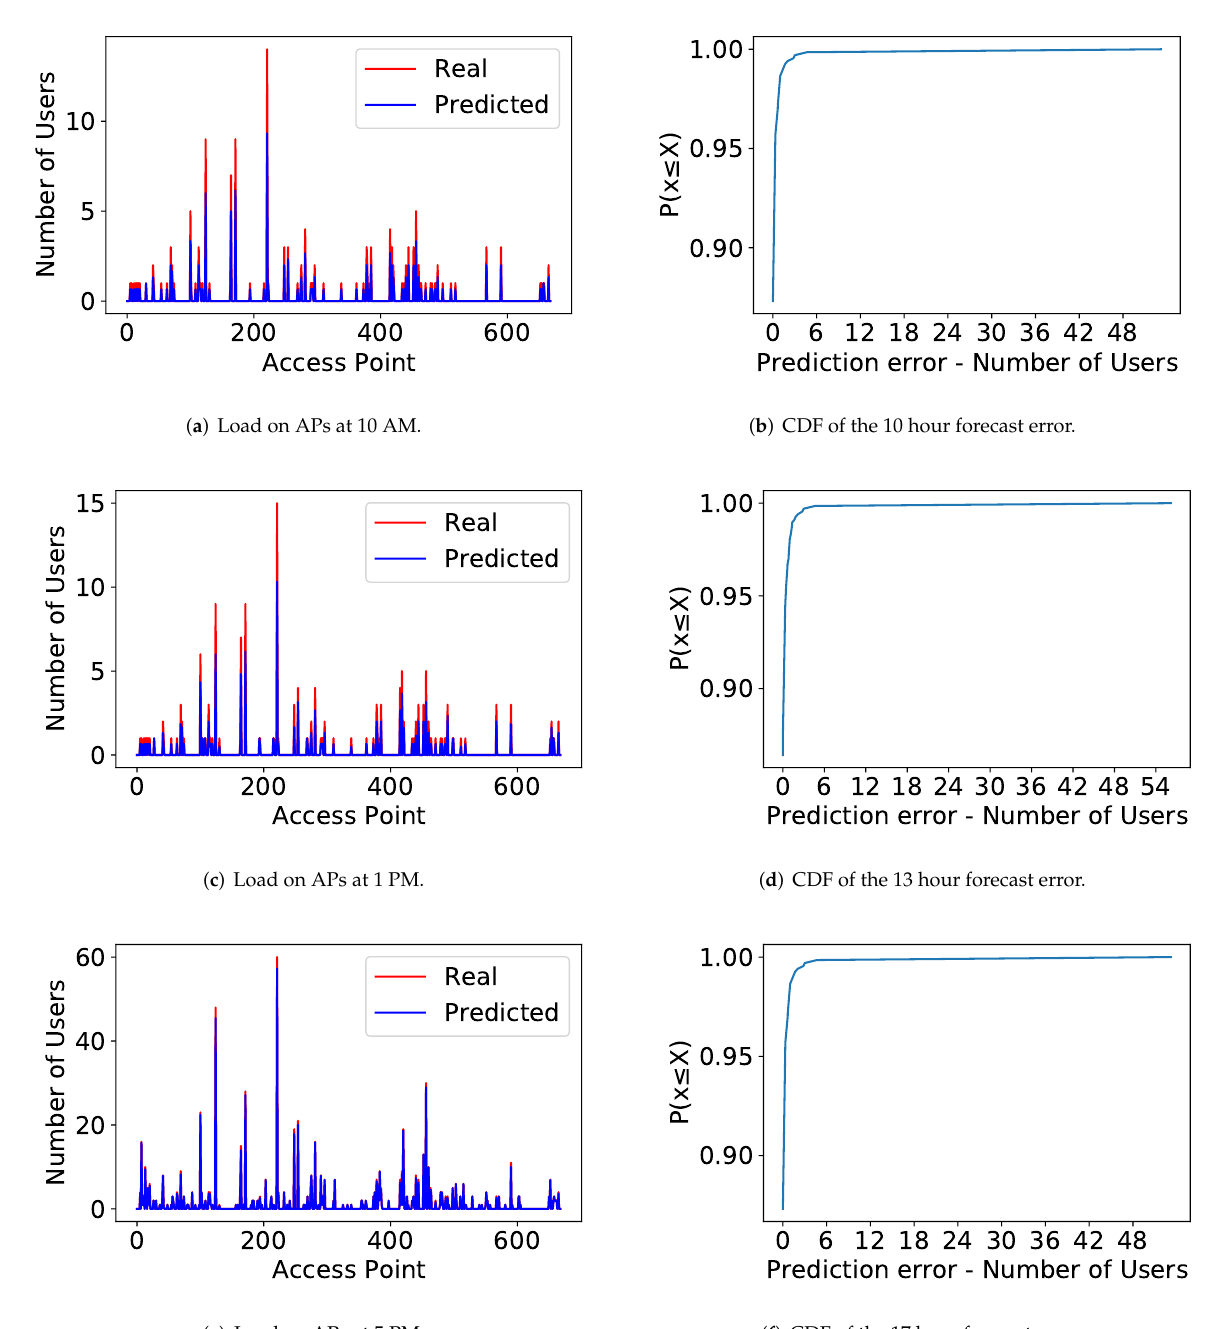
Figure 2. The comparison between the actual load and the load predicted load. The Cumulative Distribution Function (CDF) of the model prediction errors show that the proposed model has prediction assertiveness always above 90% for all access